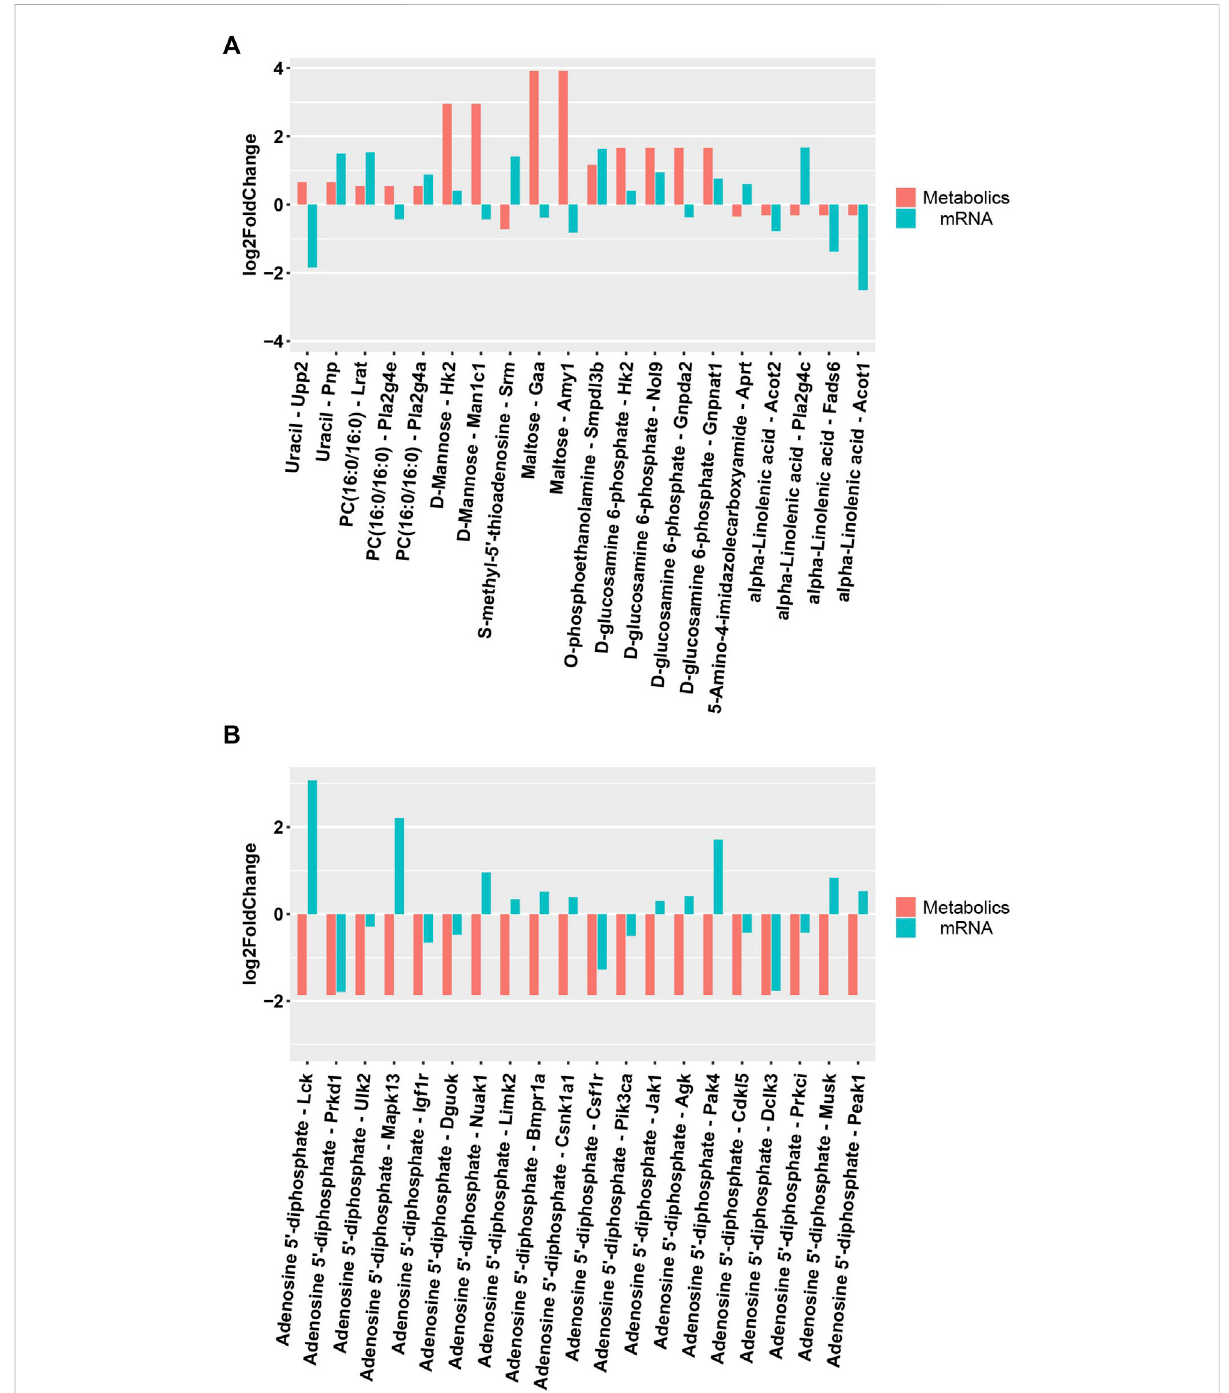
FIGURE 5 Differential expression of metabolites and related transcripts. (A) Differential expression of metabolites and related transcripts in positive ionization modes. (B) Differential expression of metabolites and related transcripts in negative ionization